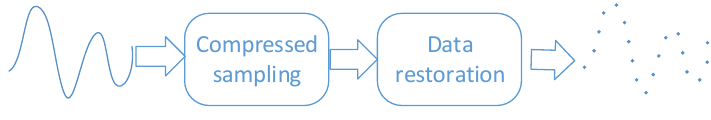
Figure 2. The process of compressed